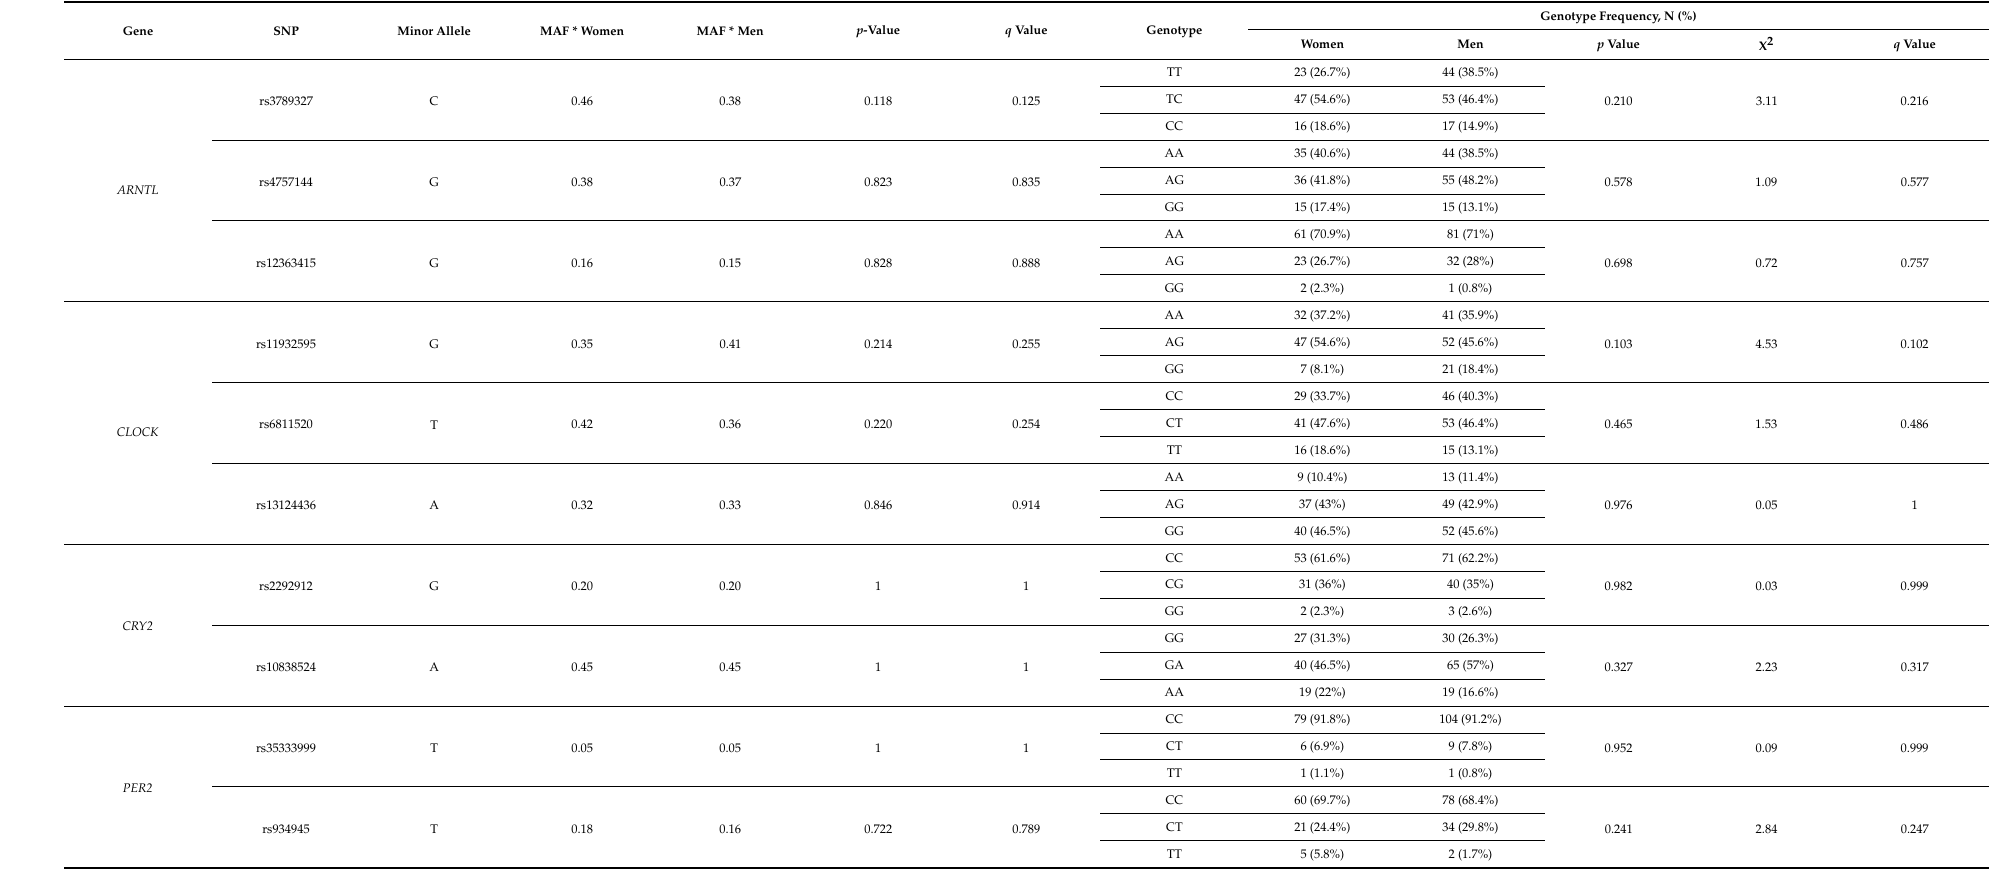
Table 4. Allele and genotype distribution and frequencies of the ARNTL , CLOCK , CRY2 , and PER2